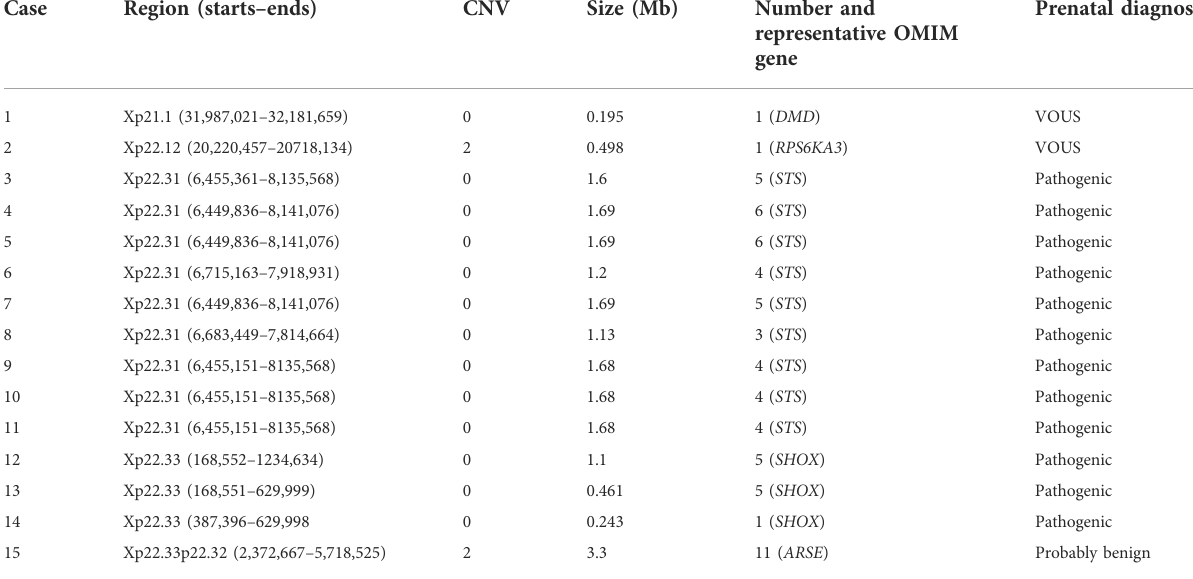
TABLE 4 X chromosomal deletions/duplications in male